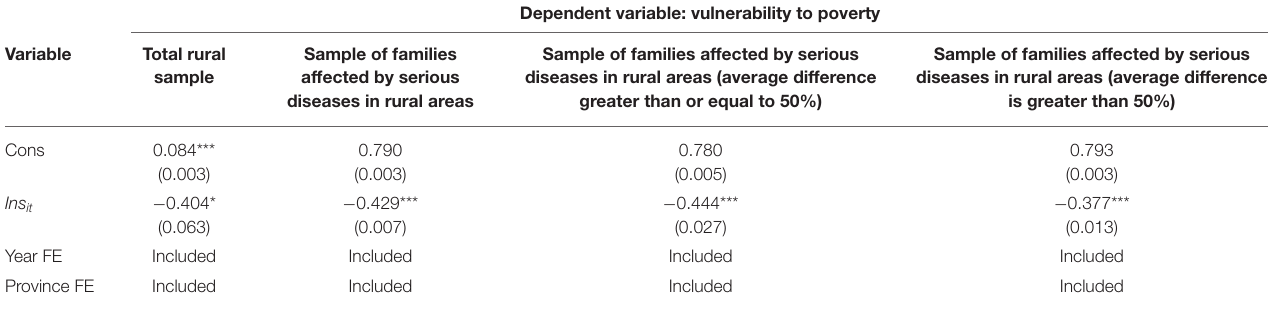
TABLE 6 | Test results of the effect of major illness insurance on vulnerability to poverty among rural residents.